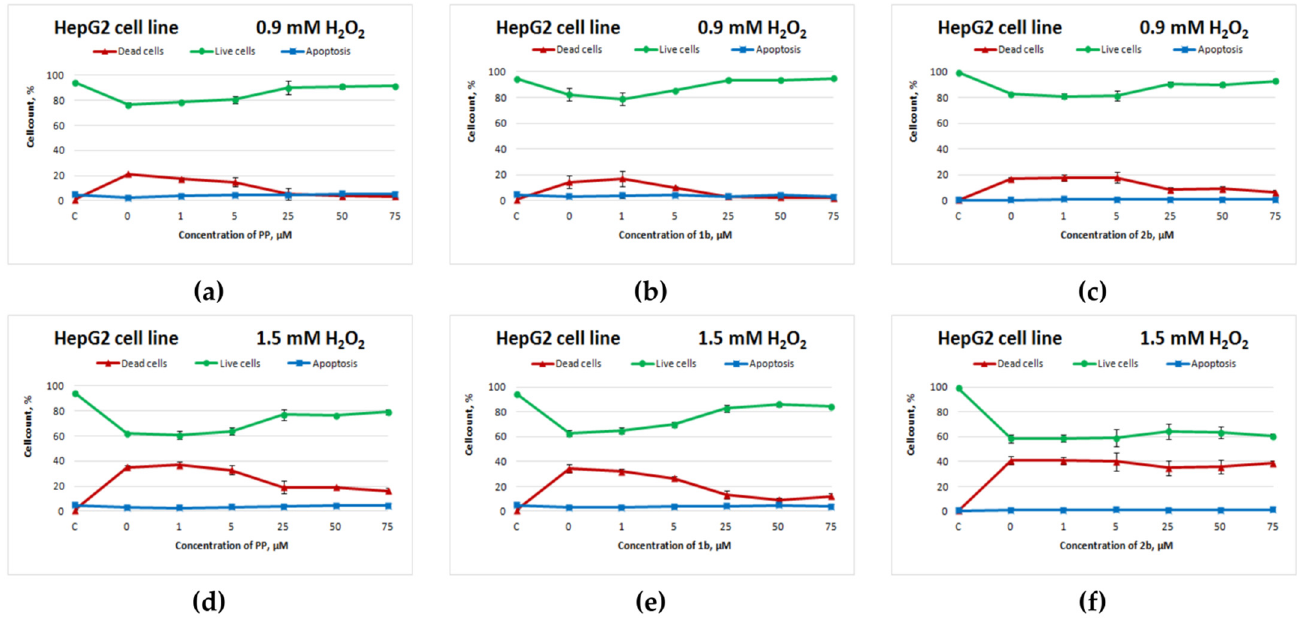
Figure 2. Effects of potassium phenosan [ PP , potassium salt of potassium 3-(3,5-di-tert-butyl-4-hydroxyphenyl)propionate], potassium 3-[3-(3,5-di-tert-butyl-4-hydroxyphenyl)propylseleno]propionate ( 1b ) or potassium 3-[4-hydroxy-3,5-dimethylbenzylthio]propanoate ( 2b ) on the viability of HepG2 cells under the in- fluence of H 2 O 2 as determined by dual staining with Hoechst 33342/propidium iodide. Cells were cultured in the presence of each salt for 24 h, after which they were exposed to H 2 O 2 for 4 h. Point C represents control cells without treatment with hydrogen peroxide. ( a – c )—effect of PP , 1b and 2b on the viability of tumour cells under the influence of 0.9 mM H 2 O 2 , respectively, ( d – f )—effect of PP , 1b and 2b on the viability of tumour cells under the influence of 1.5 mM H 2 O 2 , respectively. Selenium-containing salt 1b exerted an antioxidant action on HepG2 cells (Figure 2b,e) that was comparable to the action of potassium phenosan (Figure 2a,d) at 0.9 and 1.5 mM H 2 O 2 (starting from 25 µM, the percentage of live cells was higher as compared to the control without compounds). Sulphur-containing salt 2b had a positive effect on cell vi- ability only when the cells were exposed to 0.9 mM H 2 O 2 (Figure 2c). Potassium phenosan and 2b did not show an antioxidant activity against MCF-7 cells (Figure 3a,d,c,f). Compound 1b , on the other hand, exerted an antioxidant action on MCF-7 cells in the concentration range from 1 to 25 µM, but starting from 50 µM, cell death sharply increased and significantly exceeded cell death in the control with H 2 O 2 (Figure 3b,e). Without exposure to H 2 O 2 , this negative effect of 50 µM 1b on cell viability was absent (Figure S6h).